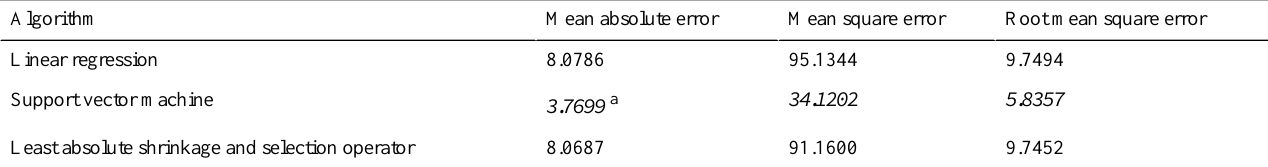
Table 7. Regression results on the third